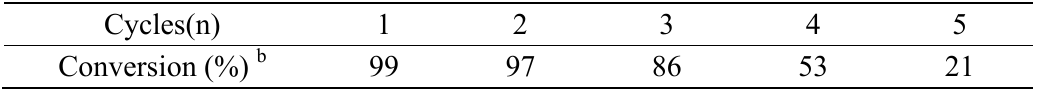
Table 3. Recycling of catalyst a